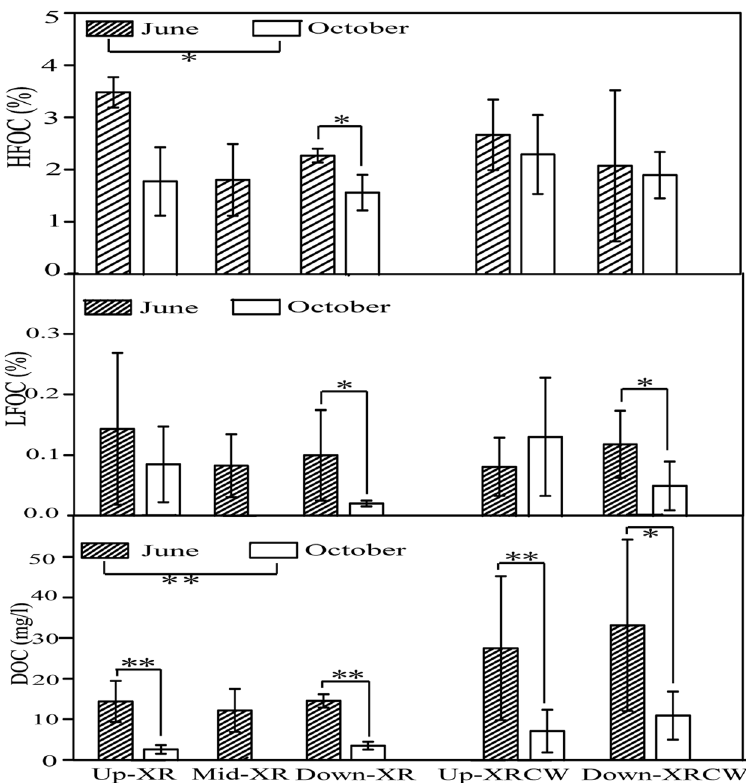
Figure 4. Seasonal differences of the carbon fractions (HFOC, LFOC, and LFOC) in Xinxue River (XR) and Xinxue River Constructed Wetland (XRCW). * P < 0.05, ** P < 0.01 (Duncan